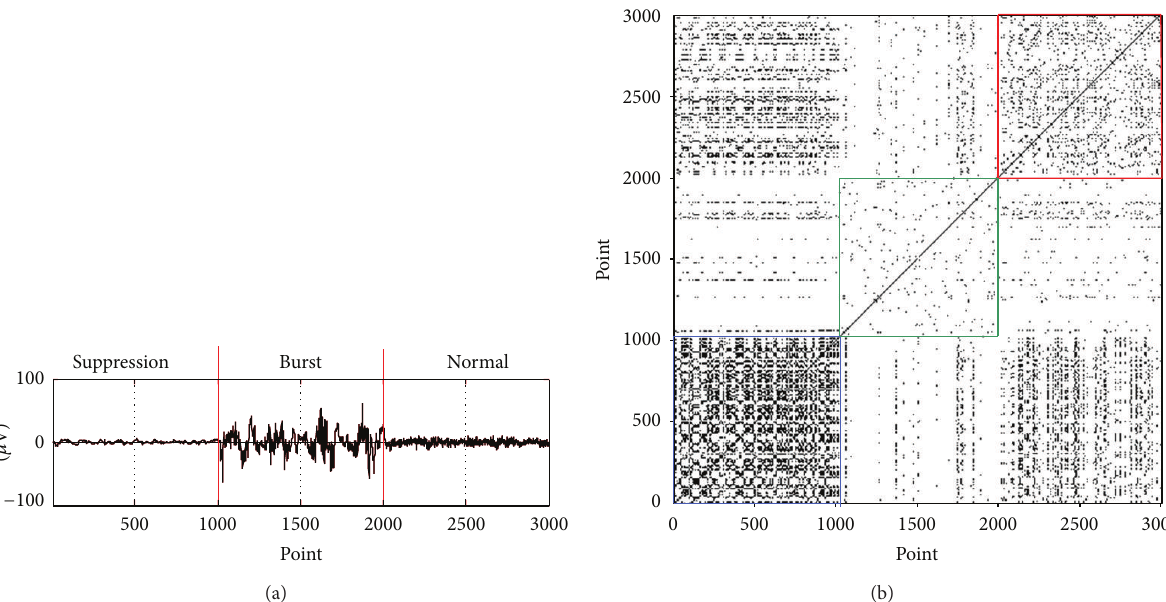
Figure 2: (a) A composite EEG signal from a patient. It consists of suppression (1000-point), burst (1000-point), and normal (1000-point) records artificially joined together; (b) different RP patterns during suppression, burst, and normal states, respectively. The blue box represents the suppression, the green box the burst, and the red box the normal